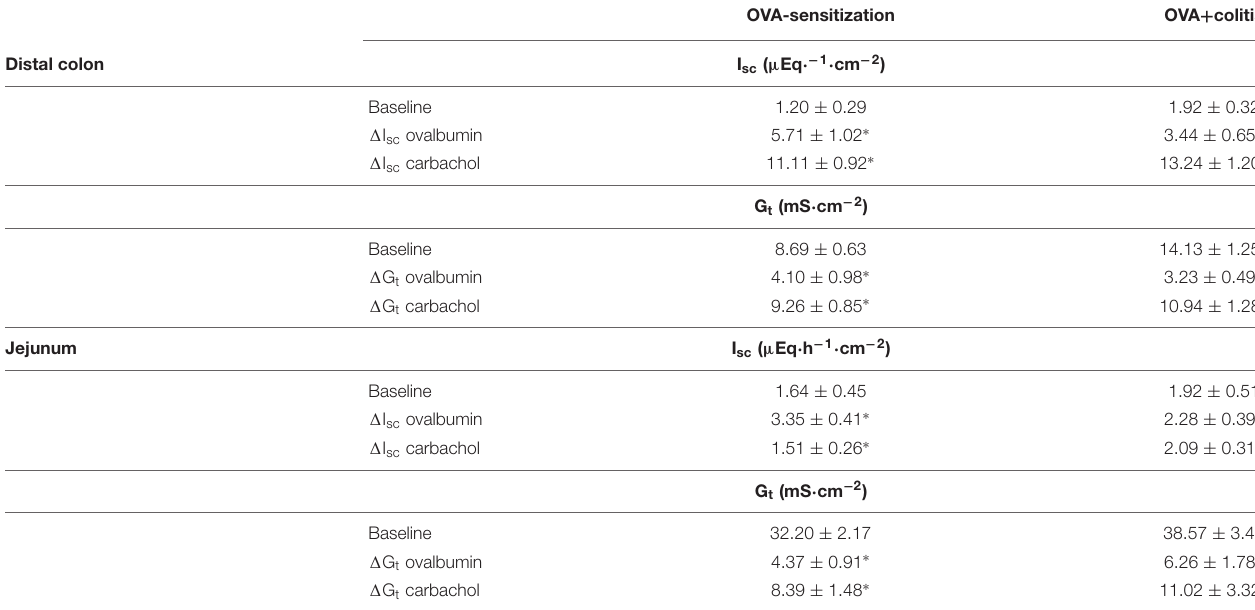
OVA-sensitization